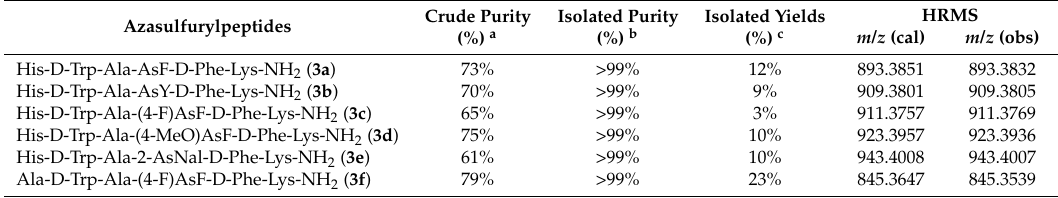
a Crude purities of peptide obtained after an aliquot cleavage of resin using TFA:H 2 O:TES (95:2.5:2.5), followed by LC-MS analysis using 5–80% MeOH (0.1% FA) in H 2 O (0.1% FA) as eluant. b Isolated purities of peptide obtained by a LC-MS analysis using two separate gradients of MeOH (0.1% FA) in H 2 O (0.1% FA) or MeCN (0.1% FA)